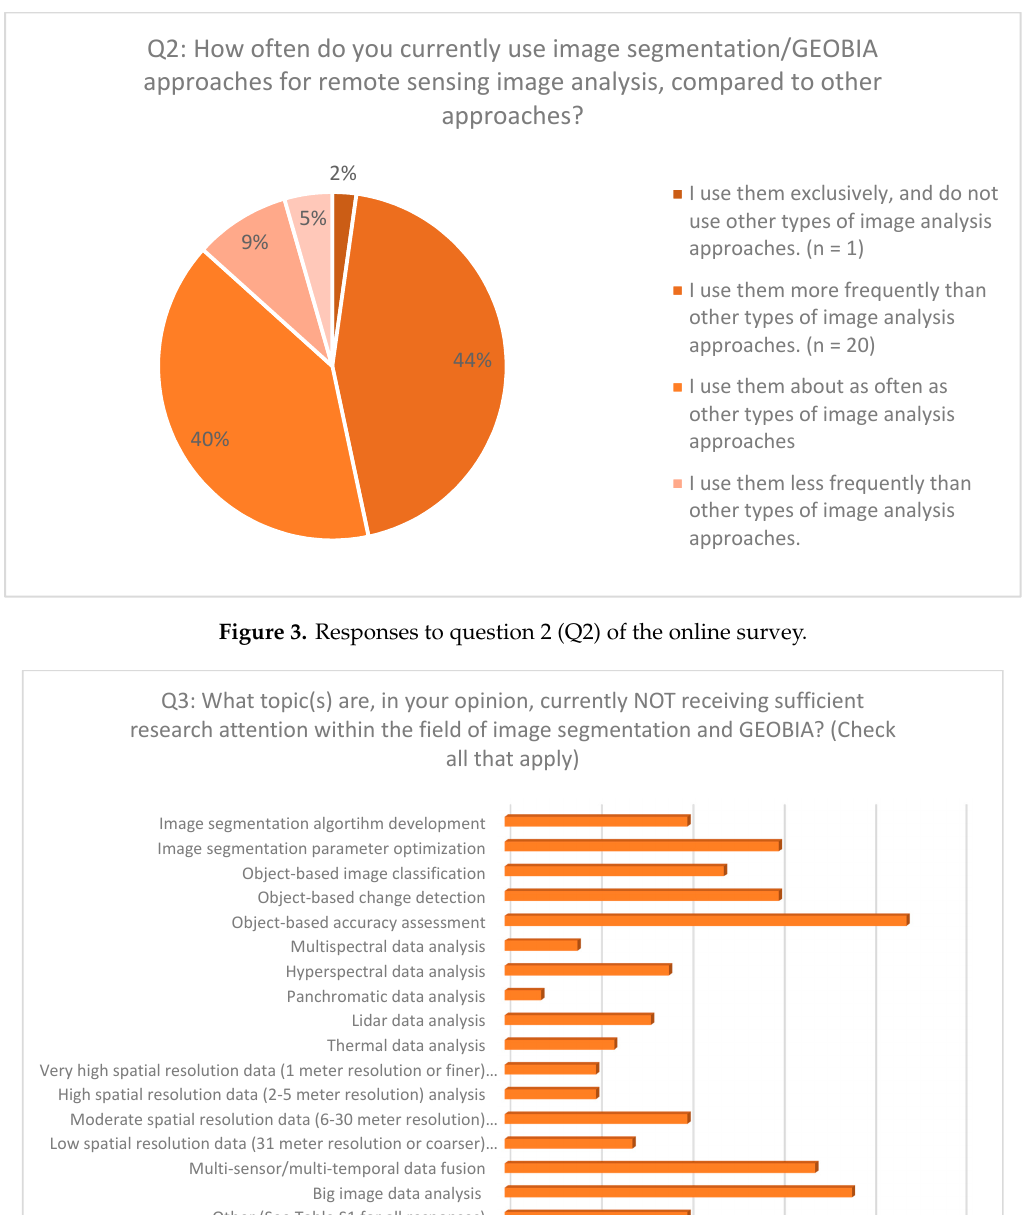
Figure 2. Responses to question 1 (Q1) of the online survey.